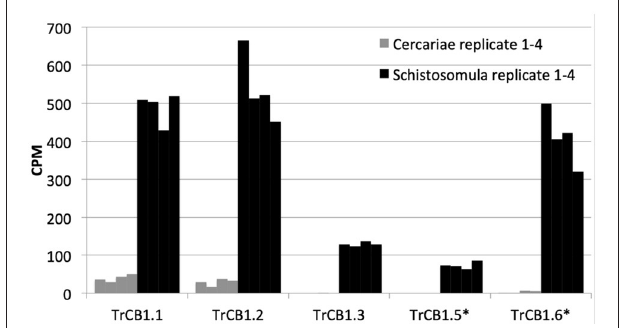
FIGURE 12 | Expression profiles of TrCB1 forms. Bar charts show the level of expression of different forms of cathepsin B1 in cercariae (gray) and schistosomula (black) of T . regenti based on mapping of RNA-seq data obtained from cercariae and 7-days old schistosomula. The level of expression is expressed in counts per million (CPM) of mapped reads. Each column is a cluster of four biological replicates. Inactive paralogs are indicated by